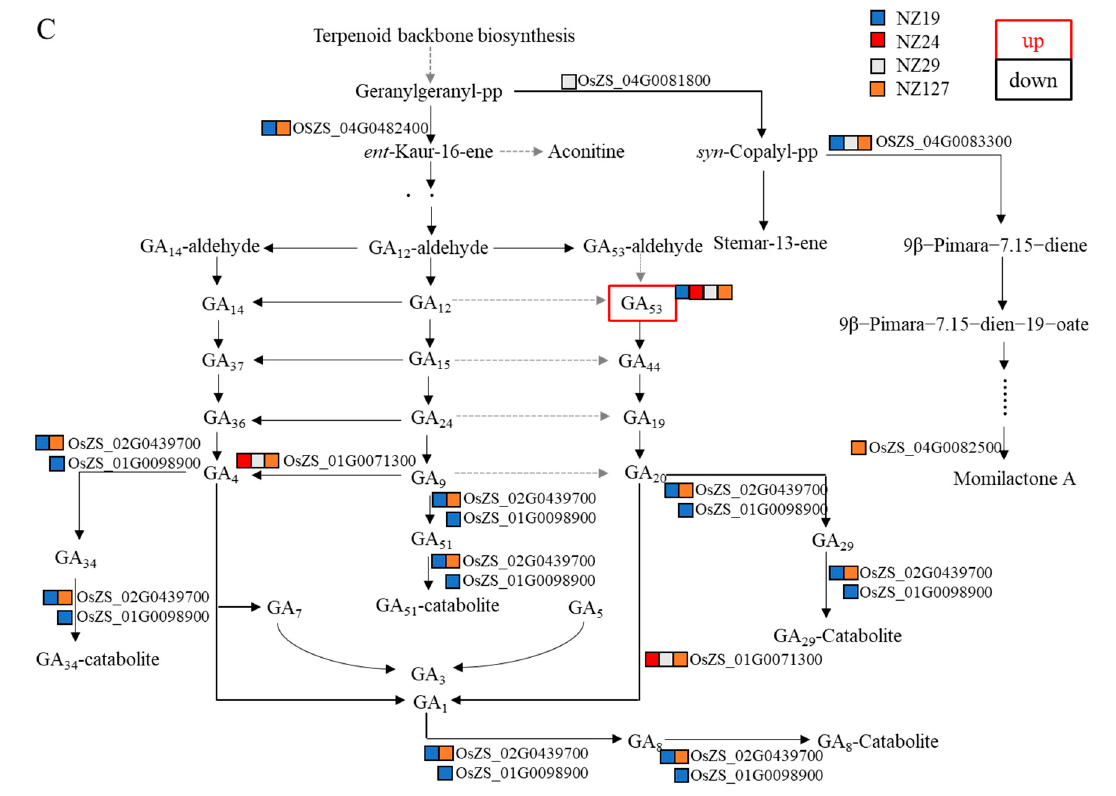
Figure 12. Differential expressed genes and differential accumulated metabolites mapped on diterpenoid biosynthesis pathway of embryo ( A ), endosperm ( B ), and aleurone layer ( C ). The diagram shown is based on KEGG pathway maps (https://www.ge-